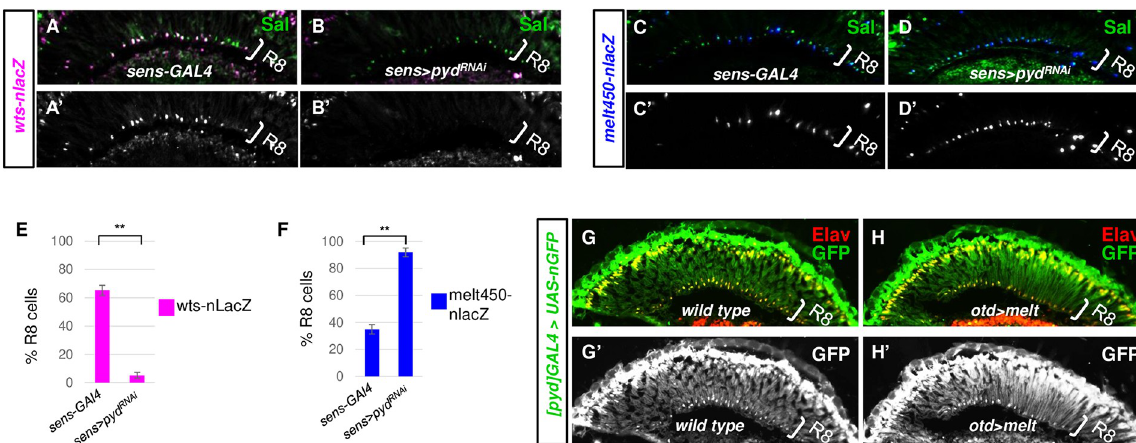
Fig 4. pyd regulates the expression of wts and melt , while pyd expression is not regulated by wts or melt . (A-B) Cryosections of adult eyes immunostained for LacZ (magenta) and the R8/R7 marker Spalt (Sal, green) showing the expression of wts in control (A) and pyd knock-down (B, sens > pyd RNAi-KK105581 ) eyes. Sal labels all R8 cells. (C-D) Cryosections of adult eyes immunostained for LacZ (blue) and the R8/R7 marker Sal (green) showing the expression of melt450 in control (L) and pyd knock-down (M, sens > pyd RNAi-KK105581 ) eyes. (E-F) Quantification of wts - expressing (E) or melt450 -expressing (F) R8s in control ( sens-GAL4 ) and pyd knock-down R8 cells ( sens-GAL4 > pyd RNAi-KK105581 ). y axis presents proportion of R8s that express LacZ. �� P < 0.001. Error bars represent standard deviation. (E) sens-GAL4 : n = 6 retinas, n = 956 R8s; sens > pyd RNAi : n = 6 retinas, n = 905 R8s. (F) sens-GAL4 : n = 6 retinas, n = 820 R8s; sens > pyd RNAi : n = 6 retinas, n = 803 R8s. (G-H) Cryosections of adult eyes immunostained for GFP (green) and neuronal cell marker Elav (Red) in wild type (G) and melt GOF (H, otd > melt )